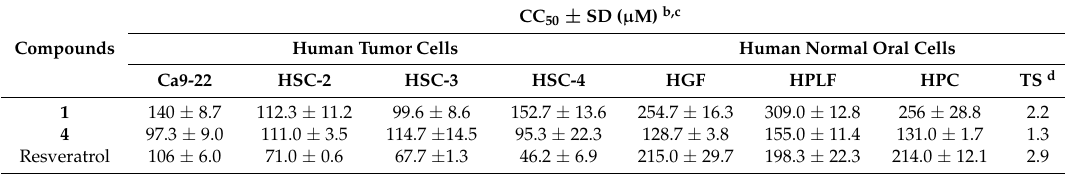
Table 2. Cytotoxicity of Davidia tannins against human normal and tumor cells. a